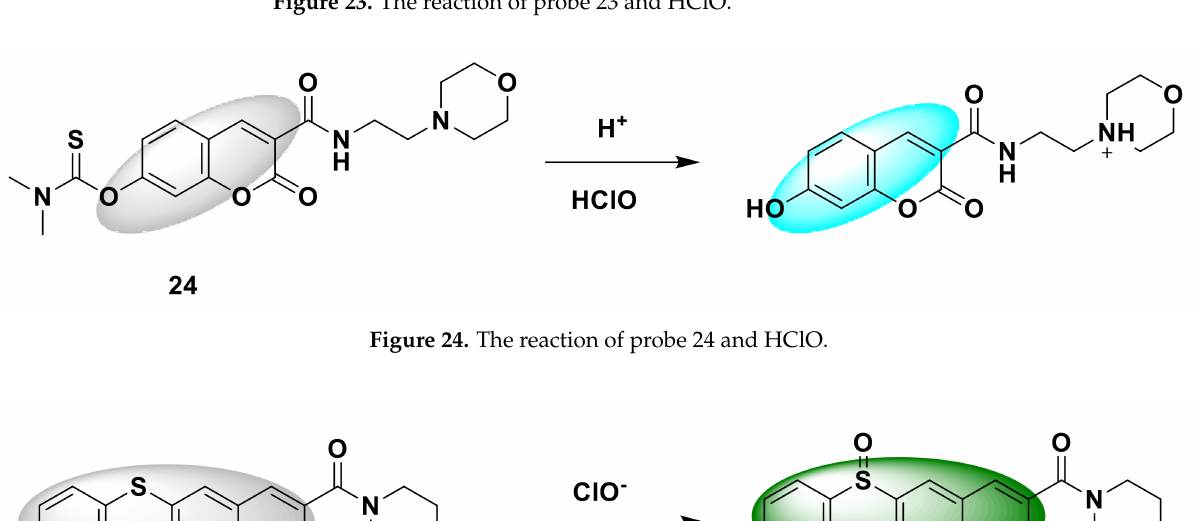
Figure 23. The reaction of probe 23 and HClO.